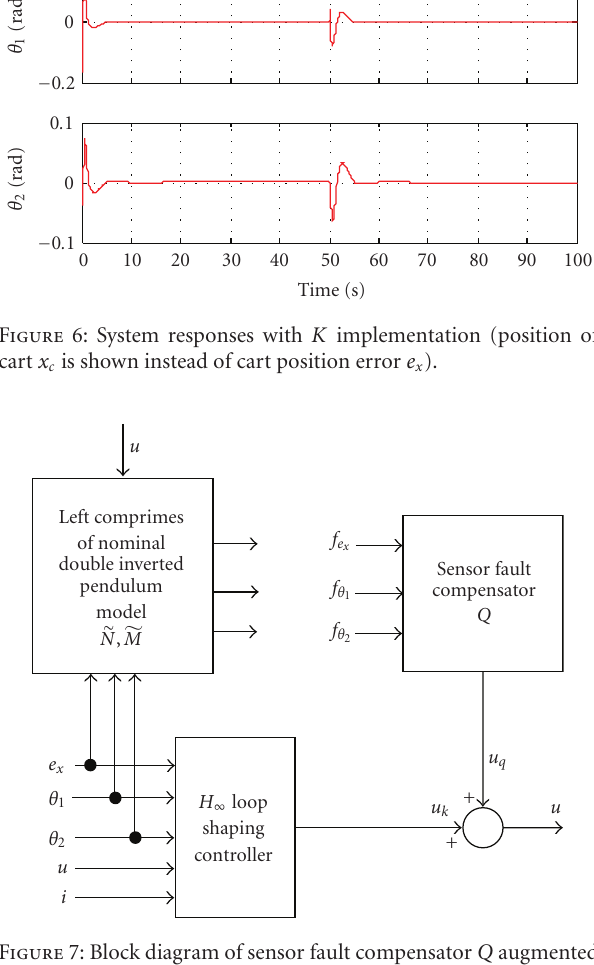
Figure 7: Block diagram of sensor fault compensator Q augmented to nominal controller K in the FTCS